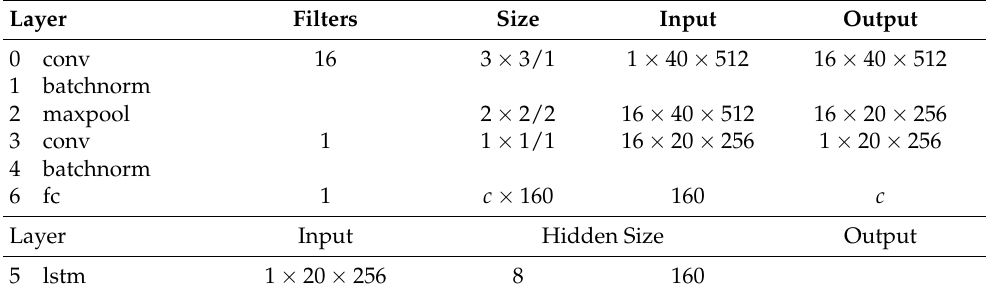
Figure 5. Structure of our CRNN. Table 1. CRNN layers and